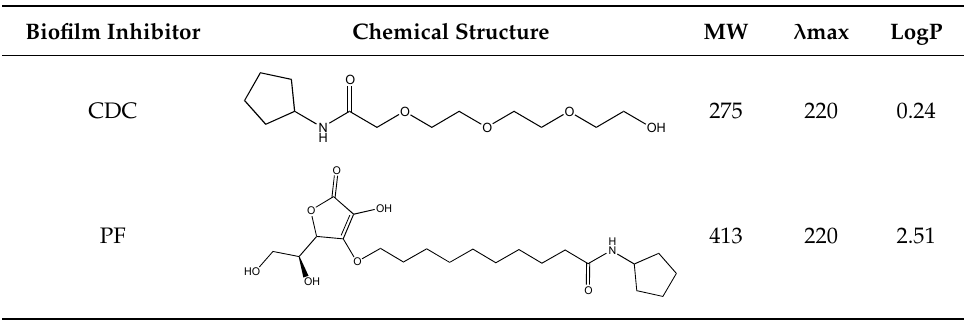
Table 1. Structure and some physico-chemical characteristics of the newly synthesized Quorum Sensing inhibitor (QSi).